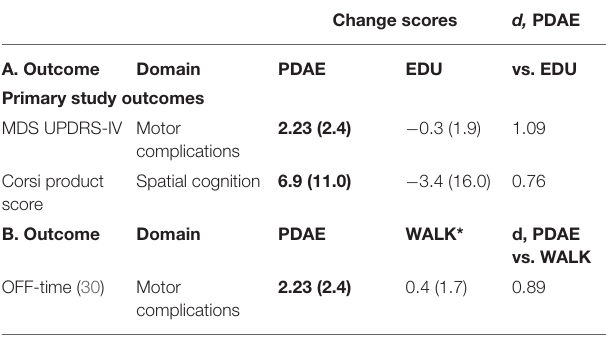
TABLE 1 | Comparison of change scores and differential effect sizes (Cohen’s d ) between 12 weeks of PDAE vs. time-matched education contact control (A) (EDU) and (B) WALK in mild–moderate